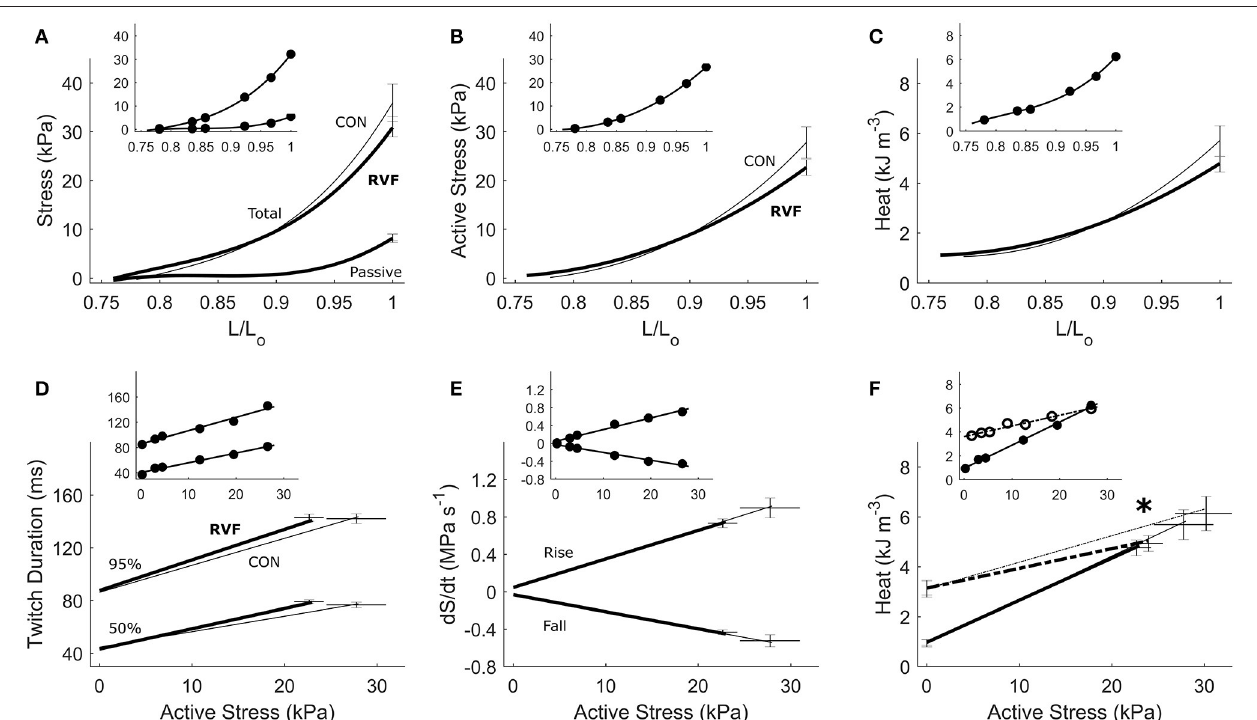
FIGURE 5 | Energetics of in vitro left-ventricular trabeculae contracting isometrically. Active stress (B) is the difference between total stress and passive stress (A) . It, and heat output (C) , as functions of relative length, were not different between the control (thin lines) and RVF trabeculae (thick lines). Likewise, no difference between groups was seen in twitch duration (D) or rates of rise and fall of the twitch ( dS/dt ) (E) . Suprabasal heat as a function of active stress was also not different between groups (F) . The dotted lines in (F) (and dotted circles in its inset) represent the heat-stress relations from the work-loop (shortening) protocol, showing a lower slope in the RVF group vs. the Control group (as indicated by the asterisk). All insets display data obtained from a representative